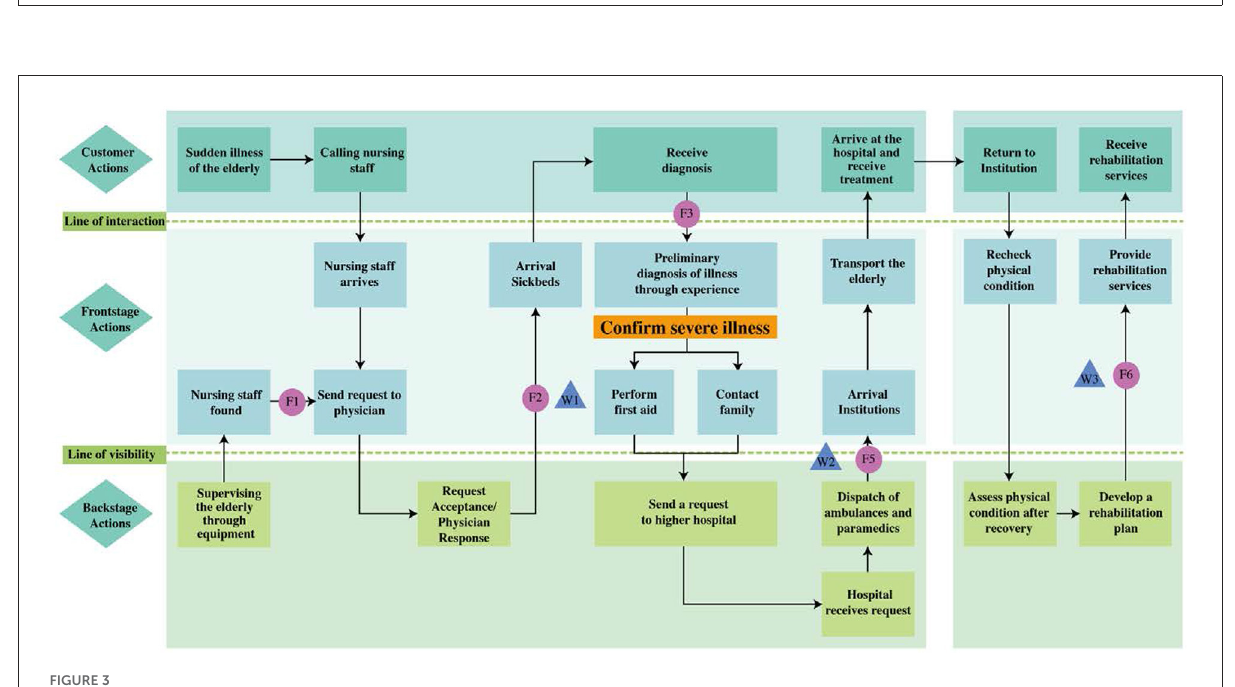
FIGURE3 Service blueprint of CMEC for elderly people with severe illness